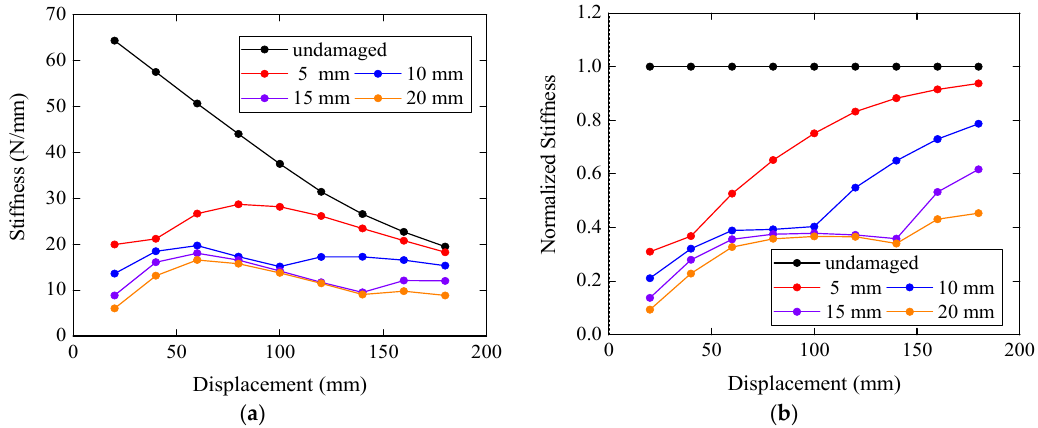
Figure 22. Stiffness and normalized stiffness ( a ) Stiffness; ( b ) normalized stiffness. Figure 22. Sti ff ness and normalized sti ff ness ( a ) Sti ff ness; ( b ) normalized sti ff